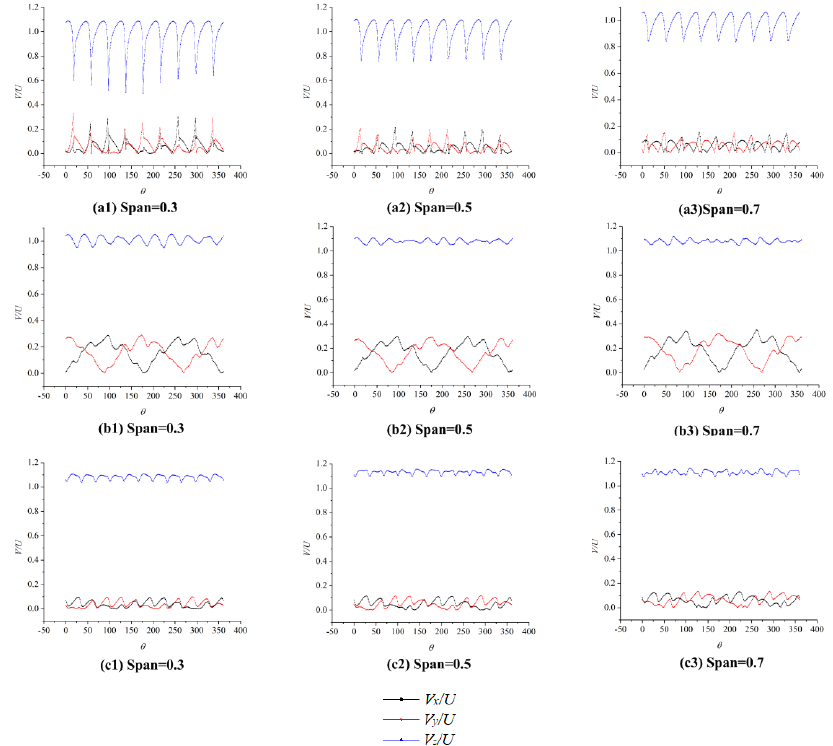
Figure 24. Velocity distribution of pump-jet designed by lifting-line method ( J = 1.12) (a1, a2, a3 are rotor inlet, b1, b2, b3 are between rotor and stator, c1, c2, c3 are stator outlet).